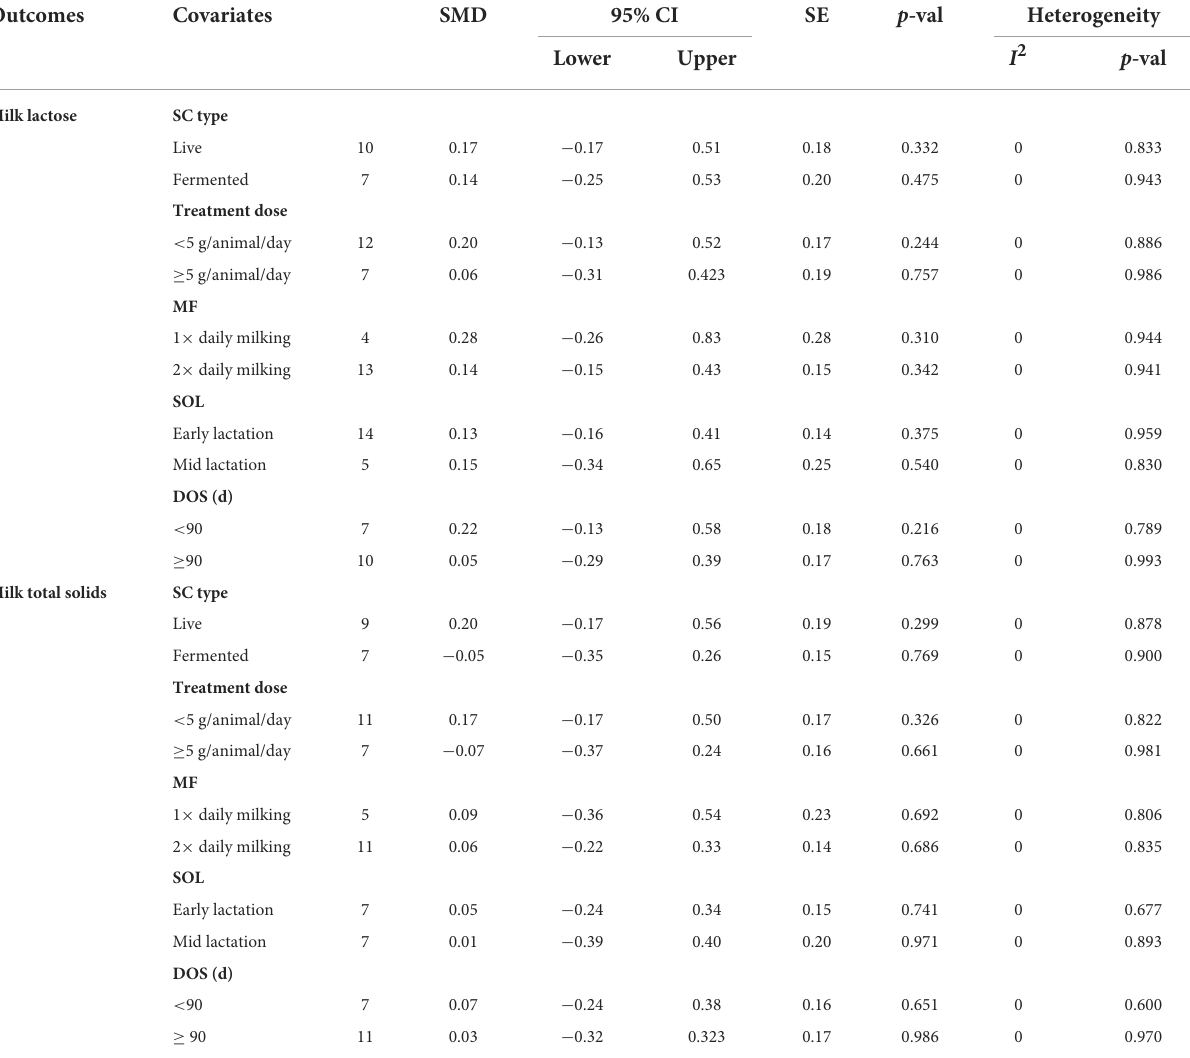
TABLE 5 Effect of covariates on milk lactose and total solids of lactating goats fed SC supplemented diets. Outcomes